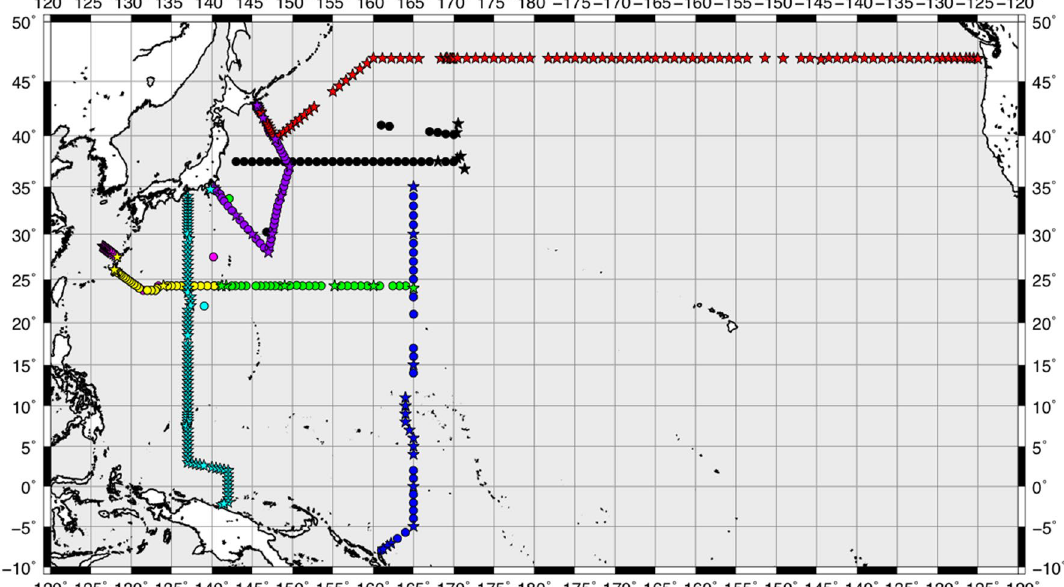
Figure 1. Station locations for 438 CTD-attached fast-response thermistor measurements. The stars denote the full-depth stations, with casts all the way down to the sea floor, and the circles represent the other casts, which extended down to a depth of 2000 m. Stations corresponding to KS16-06 with magenta colour are under KS16- 08 (green) and KS16-09 (yellow), and are masked. See Table S1 for cruise